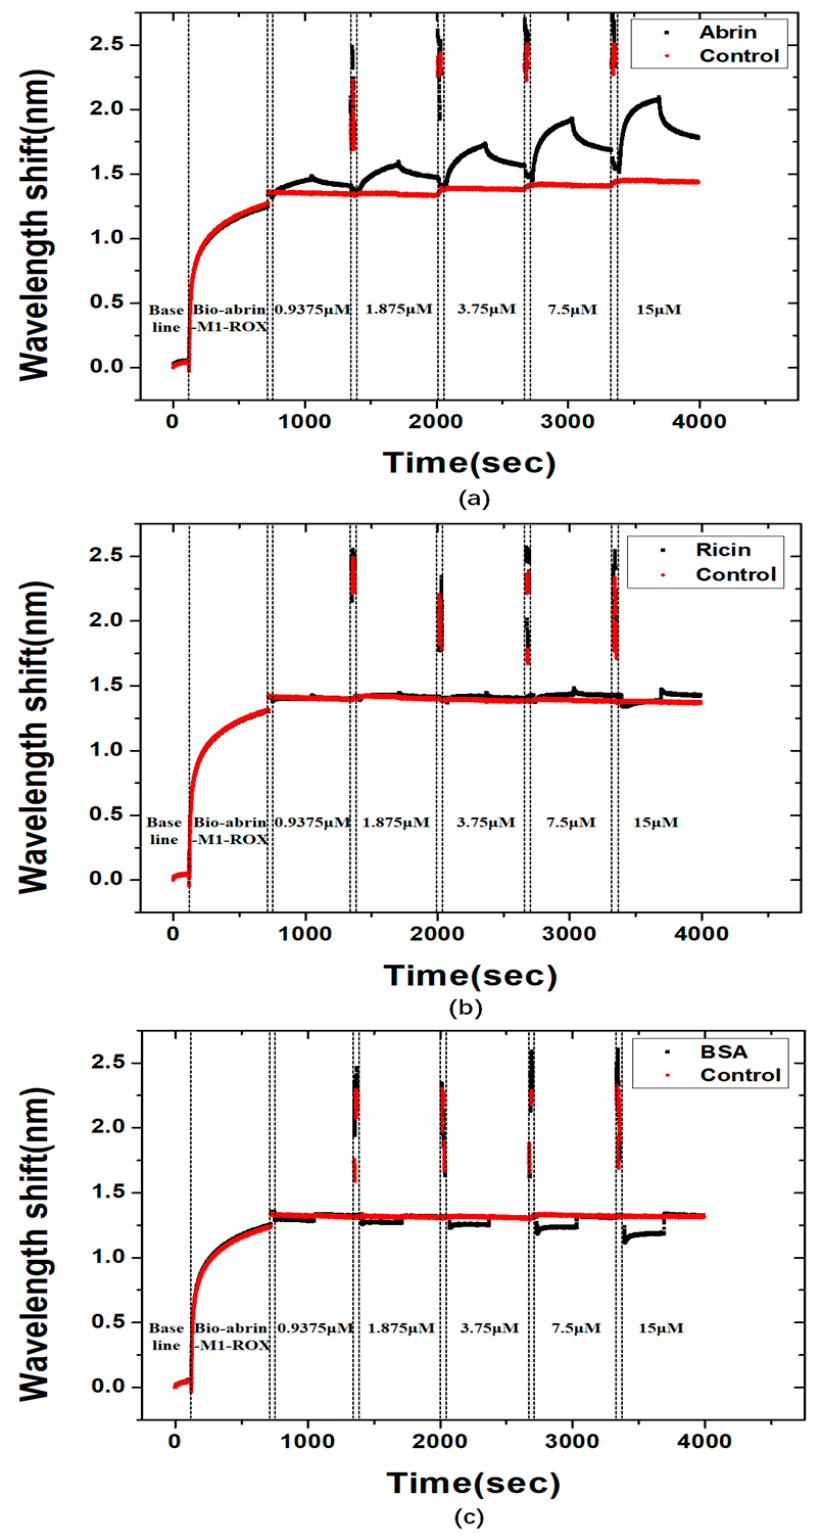
Figure 7. Association and dissociation curves of the ROX labeled abrin-M1 with different concentrations of abrin ( a ), ricin ( b ), and BSA ( c ).